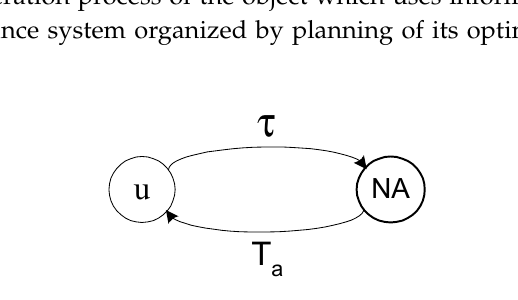
Figure 2. Graph of a model of an operation process of the object which uses information in the bivalent logic: a model with a maintenance system organized by planning of its optimal prevention activities.